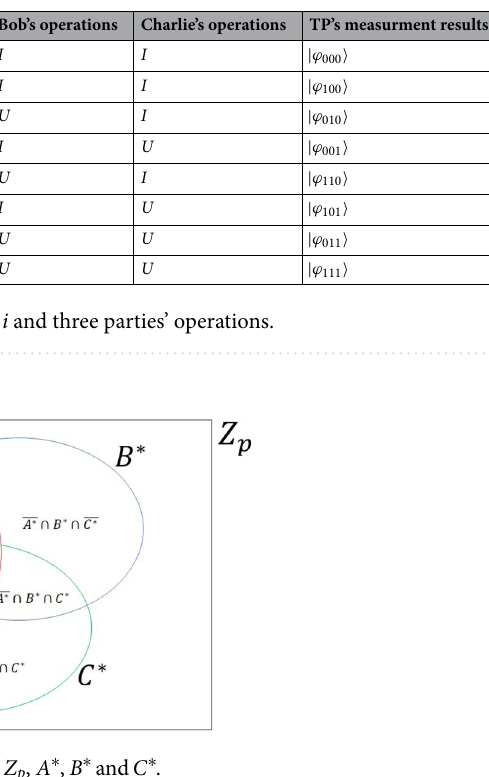
Figure 1. The relationships among Z p , A ∗ , B ∗ and C ∗